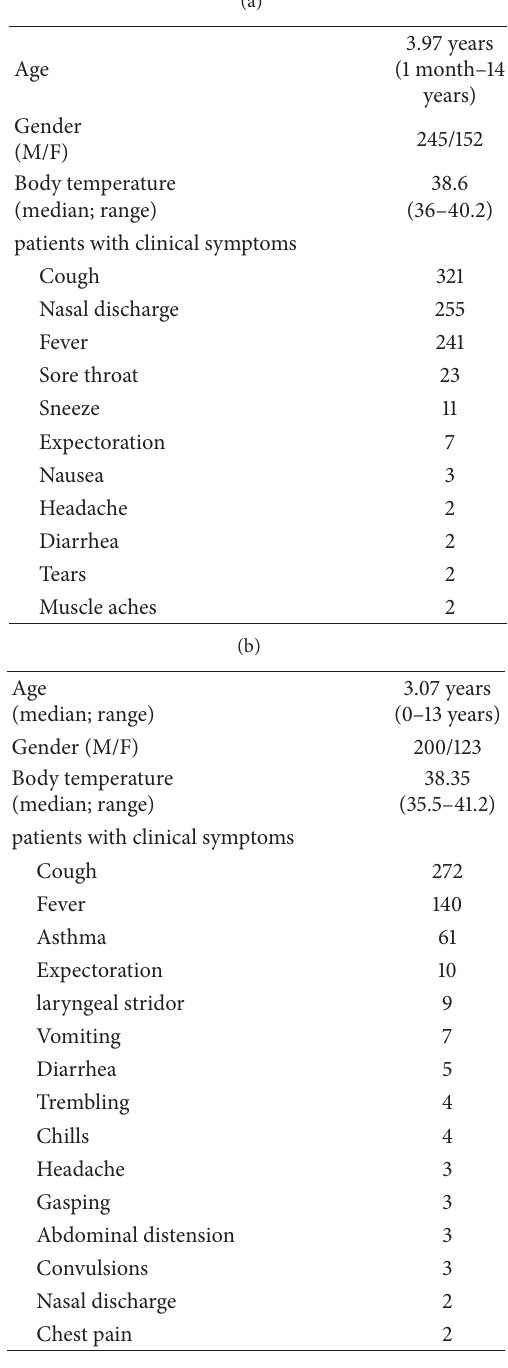
Table 1: (a) Clinical symptoms of upper respiratory infection patients tested. (b) Clinical symptoms of lower respiratory infection patients